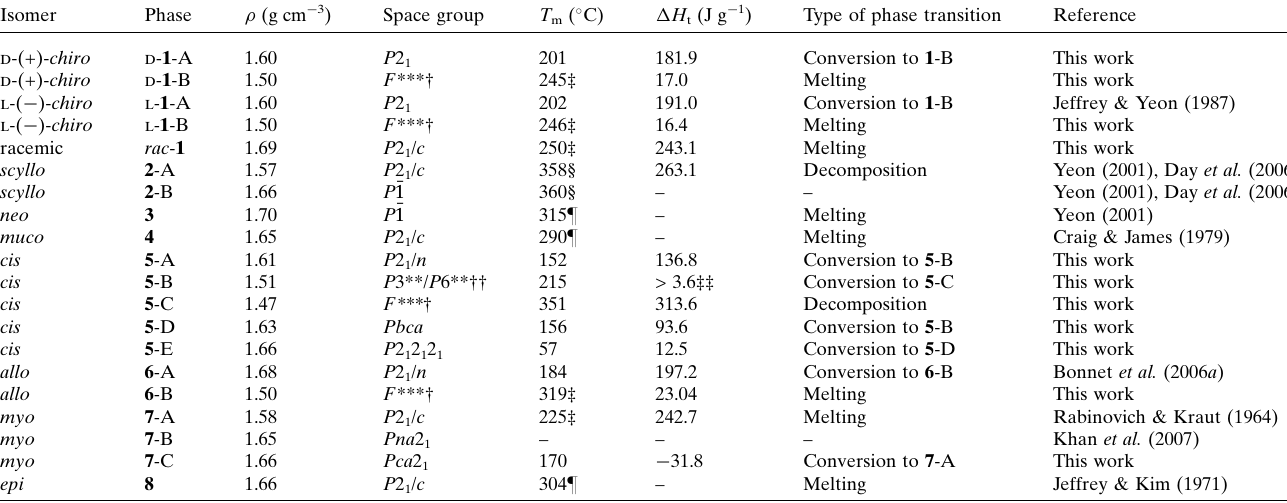
Table 1 Overview of the polymorphs (not including hydrates) of the inositols and their phase transition temperatures. Isomer